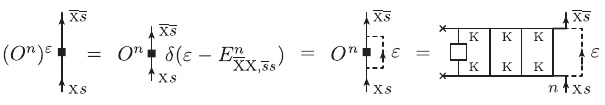
Diagrammatically, we represent the δ function in Eq. (39a) by a dashed line bracketing the symbol for the matrix element. The arrow on the dashed line points from the incoming to the outgoing energies in the corresponding − E n condition ε ¼ E n ¯ X s X ¯ s